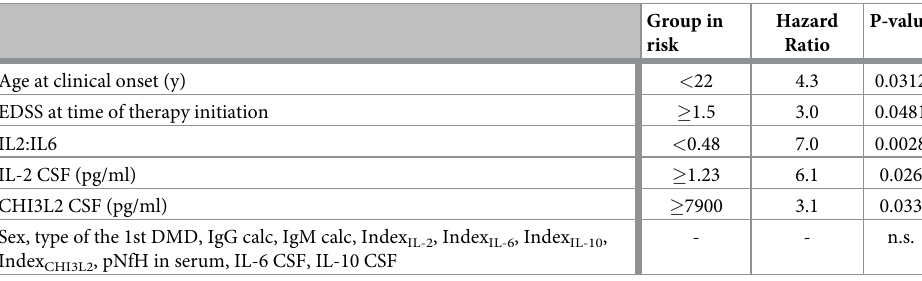
Table 3. Relapse free interval: CSF values—multivariate Cox regression model a